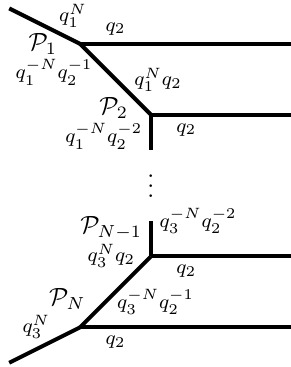
^C 2 / Z N . Each trivalent vertex